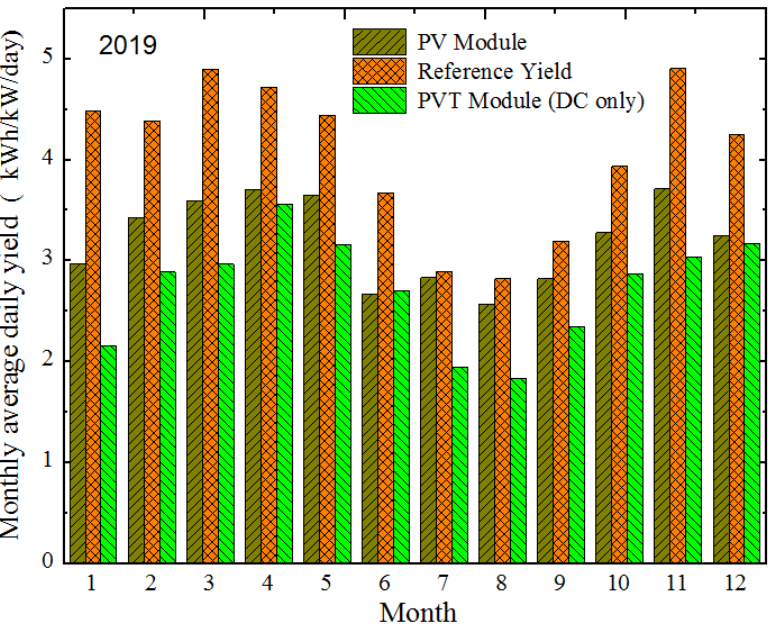
Figure 10. Array yield for PV and PVT modules compared with reference yield.